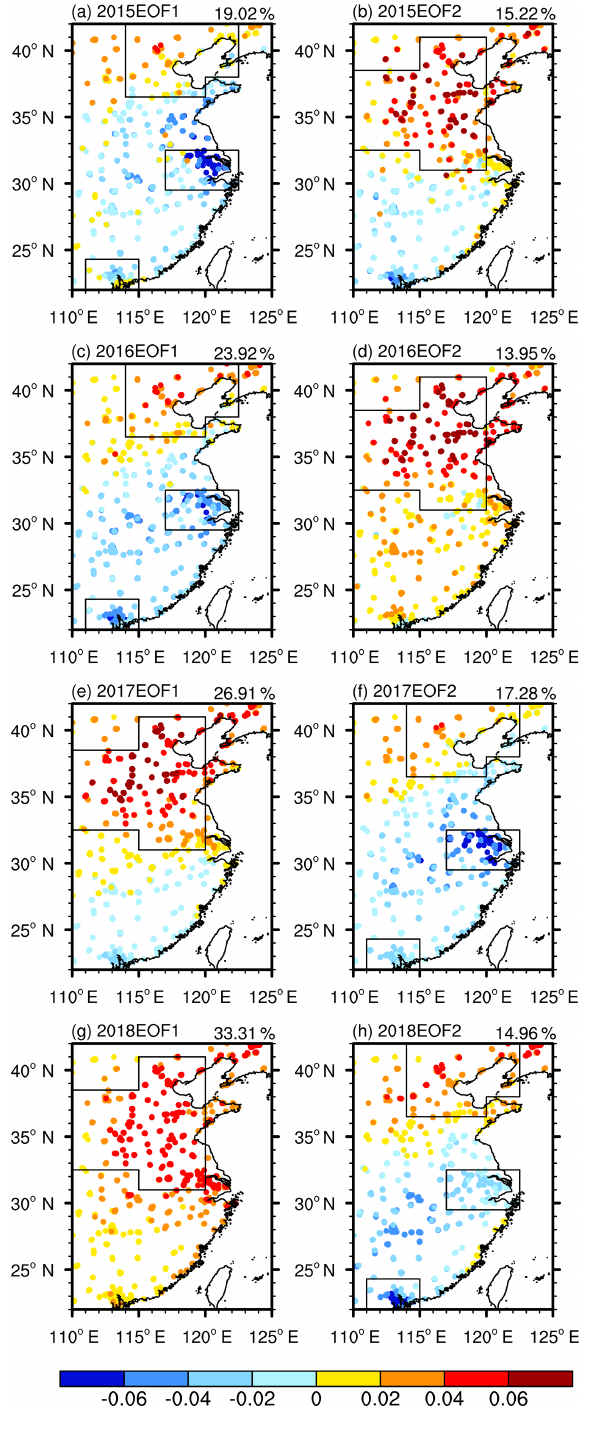
Figure 8. The first (a, c, e, g) and second (b, d, f, h) EOF spatial patterns of MDA8 in summer in 2015 (a, b) , 2016 (c, d) , 2017, (e, f) and 2018 (g, h) . The percentage number in panels (a, c, e, g) and (b, d, f, h) are the variance contributions of the first and second EOF mode; the black boxes in panels (a, c, f, h) indicate the location of NCH, YRD and PRD, respectively.The black boxes in panel (b, d, e, g) indicated the location of NH.